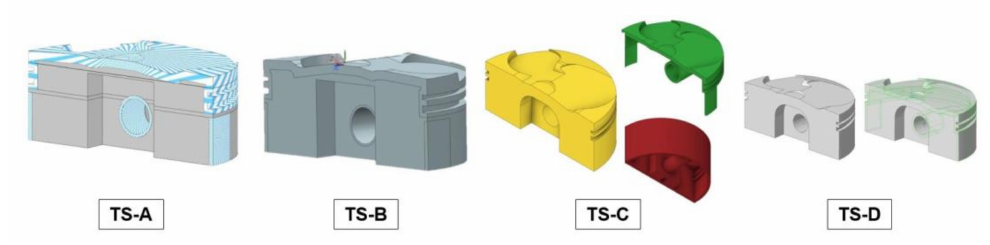
Figure 4. Design Space model respectively from TS-A, TS-B, TS-C and TS-D.